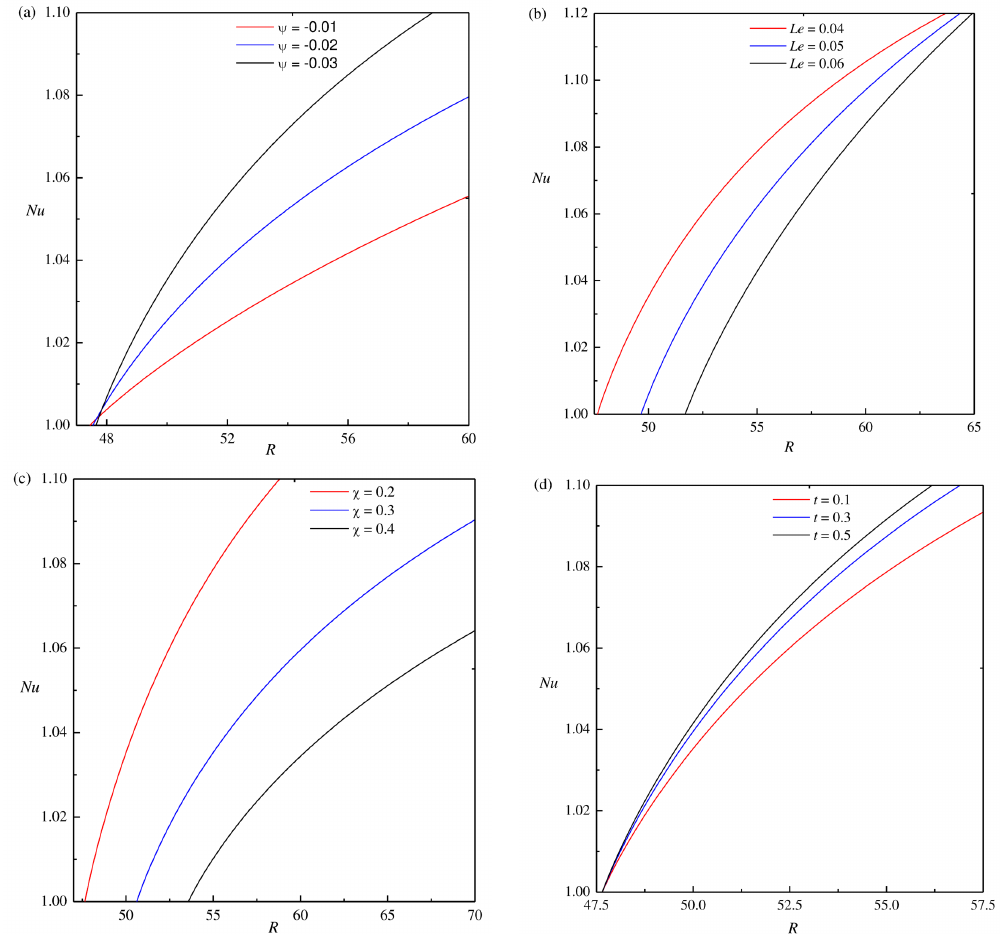
Figure 5. Dependence of Nu on R for ( a ) Le = 0.04, χ = 0.2, t = 0.1 and ψ = − 0.03, − 0.02, − 0.01, ( b ) ψ = − 0.03, χ = 0.2, t = 0.1 and Le = 0.04,0.05,0.06, ( c ) Le = 0.04, ψ = − 0.03, t = 0.1 and χ = 0.2,0.3,0.4, ( d ) Le = 0.04, ψ = − 0.03, χ = 0.2, and t =